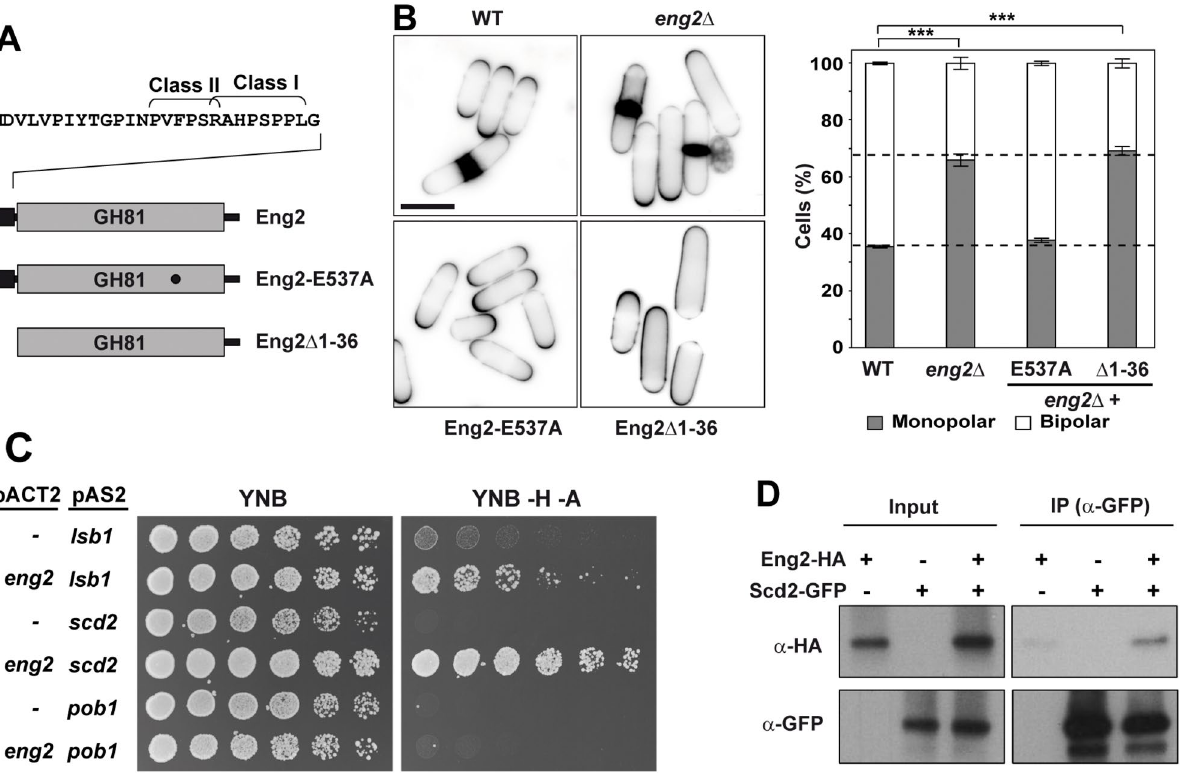
Figure 4. Eng2 interacts with the Cdc42 scaffold protein Scd2 and the glucanase activity is not required for NETO. (A) Schematic representation of Eng2 and the eng2-E537A and eng2Δ1-36 mutations. The gray rectangle indicates the Glycoside Hydrolase Family 81 (GH81) domain and the black rectangle marks the Pro-rich region. The putative SH3-interacting Class I (RxxPxxP) and Class II motifs (PxxPxR) are shown. (B) Images of calcofluor-stained wild-type and eng2 Δ cells carrying empty vector ( eng2 Δ) or vectors encoding indicated mutant proteins are shown. Scale bar, 5 μm. The graph to the right shows the average ± s.e.m percentage of monopolar and bipolar cells in wild-type, eng2 Δ and eng2 Δ mutant transformed with each construct (n > 150 from 3 independent experiments; ***p-value < 0.0001). (C) Two-hybrid analysis of the interaction between Lsb1/Csh3, Scd2 or Pob1 (pAS2) with Eng2 (pACT2). Interaction was assessed by growth on YNB plates without histidine and adenine (YNB -H -A). (D) Anti-HA (α-HA) and anti-GFP (α-GFP) immunoblots of total protein extracts (input) or Sepharose-anti-GFP immunoprecipitations (IP (α-GFP)) from cells expressing the endogenous (−) or the indicated Eng2-HA and Scd2-GFP tagged versions (+) under their endogenous